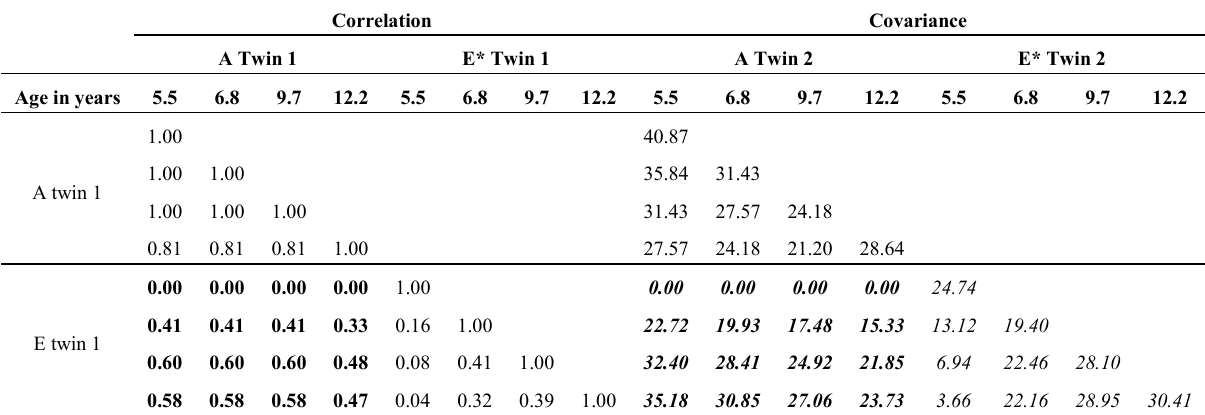
Table 5. DZ covariance matrix of A and E* in the AE* model of perfIQ with Ph->E transmission. These include the AE* covariance and AE* correlation within twins (bold italics) and between twins (bold italics) and the covariance and correlations among the twin environments (italics), which mimics the presence of shared variance. Age is given in